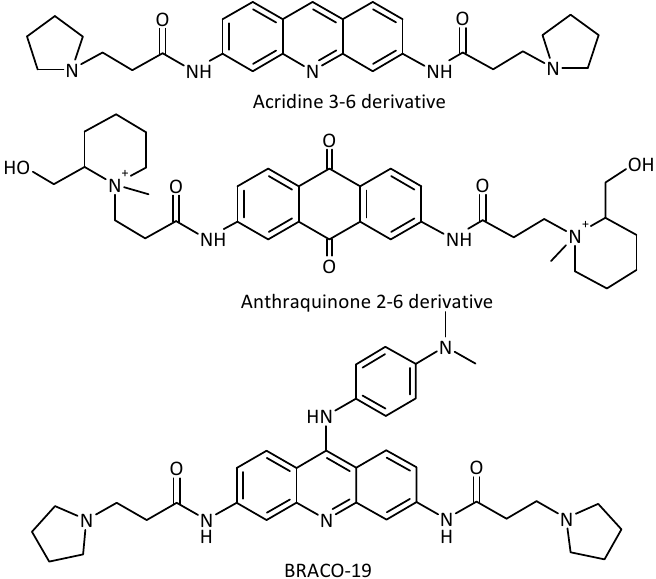
Figure 1. Examples of anthraquinone and acridine derivatives known as DNA G-quadruplex DNA G-quadruplex